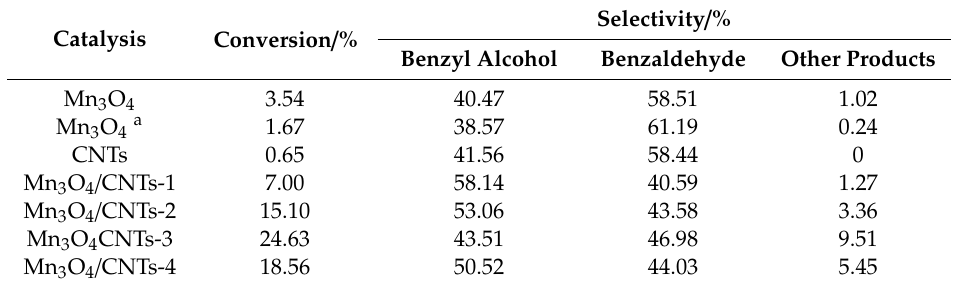
Table 2. Catalytic activity of Mn 3 O 4 / CNTs catalyst on toluene oxidation reaction.